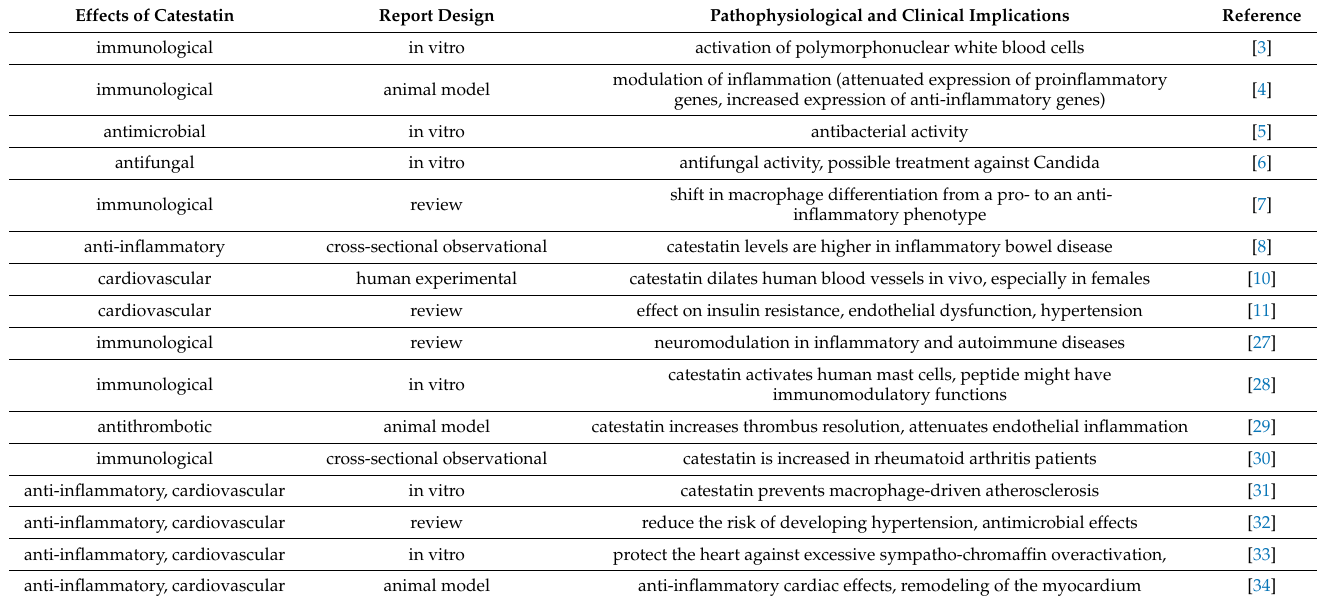
Table 7. Previous reports on the effects of catestatin on the endothelial, cardiovascular, and immuno- logical